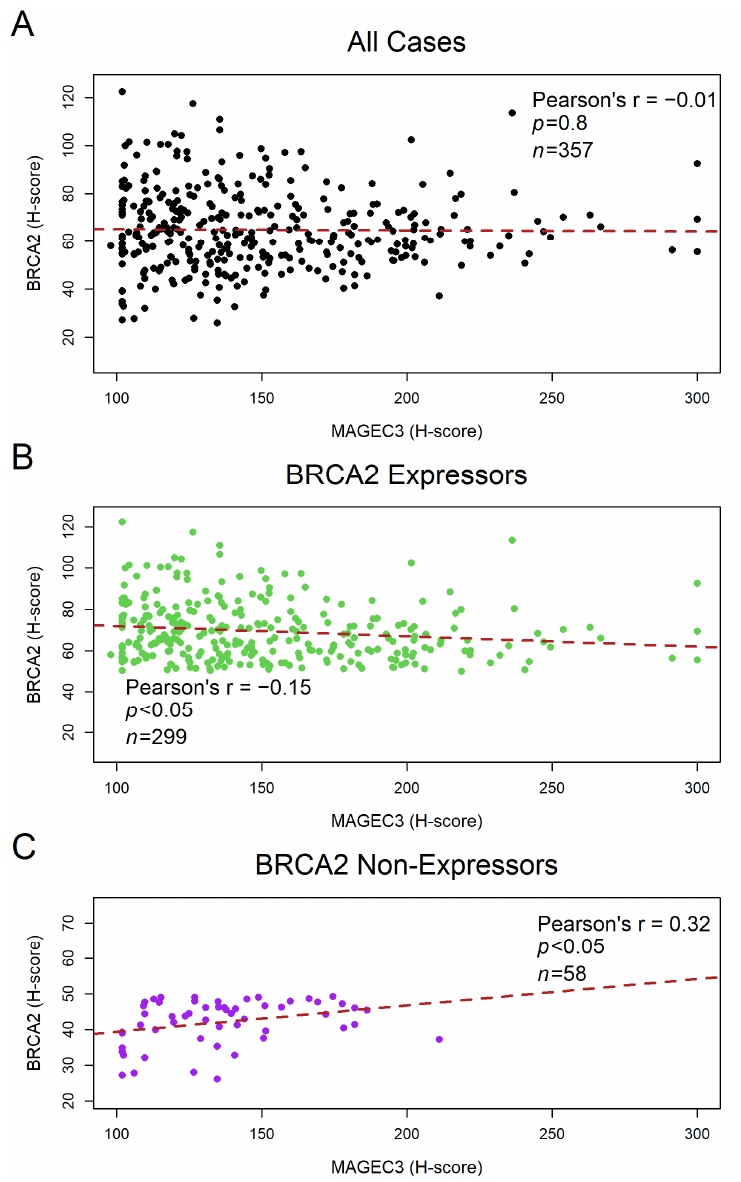
Figure 3. Correlation between MAGEC3 protein and BRCA2 C-terminal protein expression in ovarian tumor TMAs. ( A ) No correlation between MAGEC3 and BRCA2 expression in the tumor samples prior to stratification based on BRCA2 expression levels. ( B ) MAGEC3 H-scores were observed to be inversely correlated with the H-scores of BRCA2 expressors. ( C ) MAGEC3 H-scores were observed to be positively correlated with the H-scores of BRCA2 non-expressors.